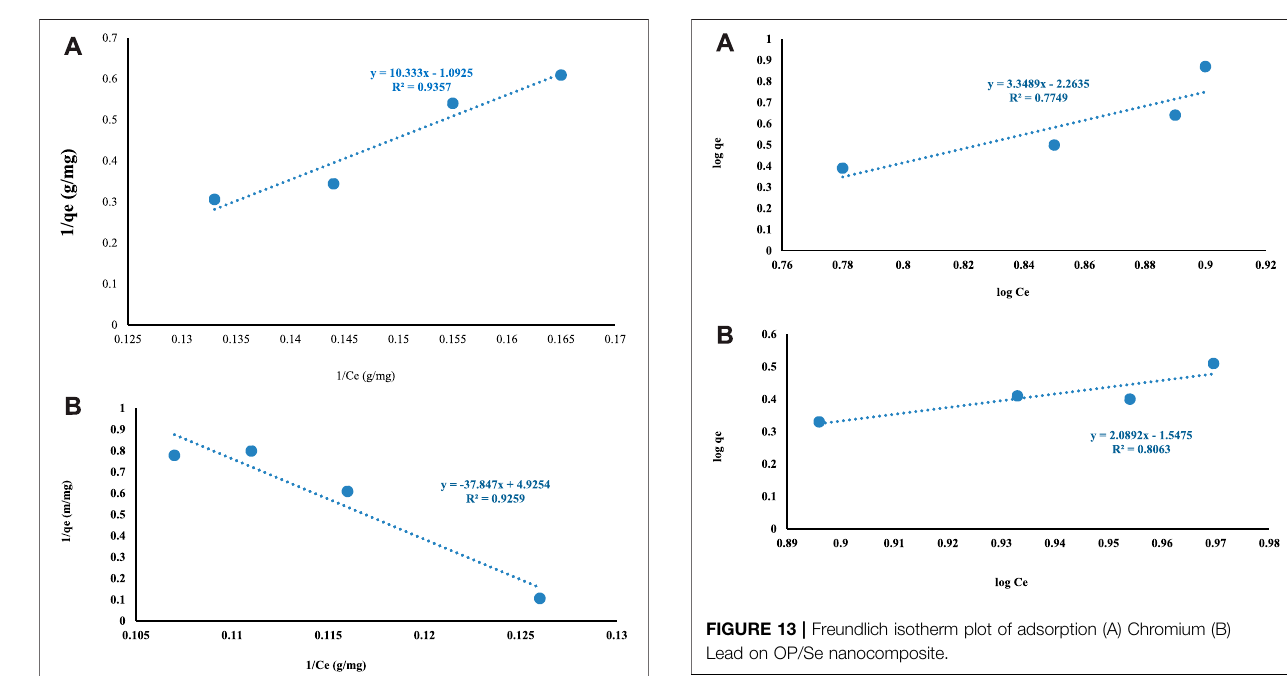
Frontiers in Environmental Science |